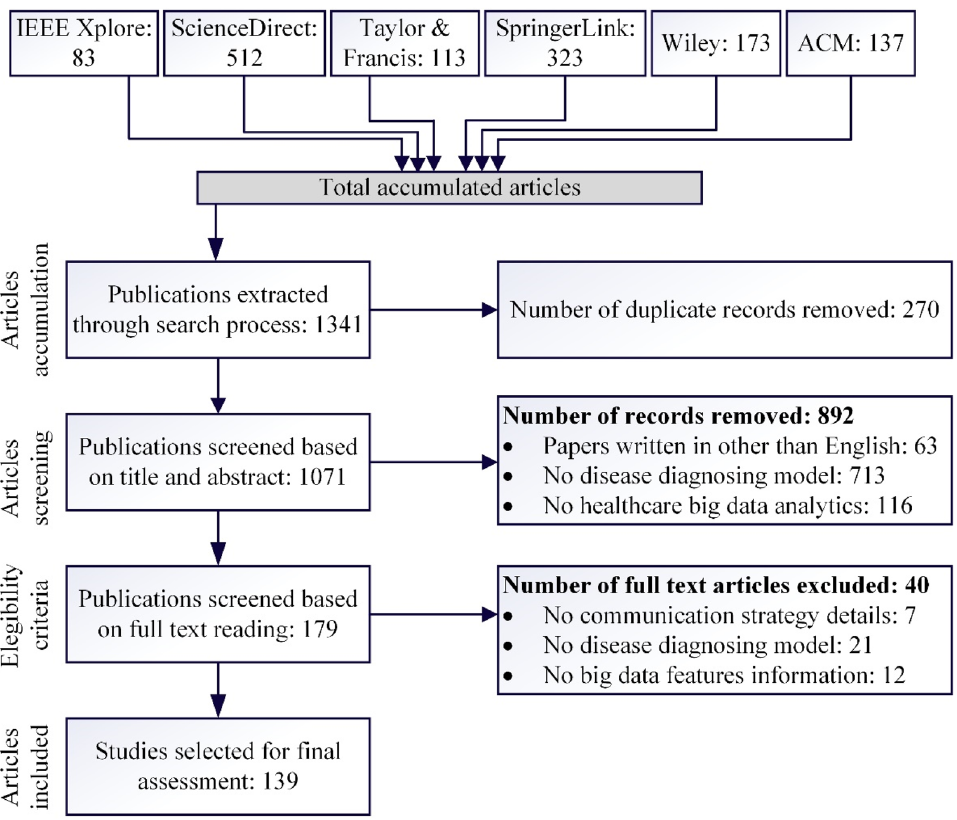
Figure 2. PRISMA process model for articles accumulation, screening, and final selection.